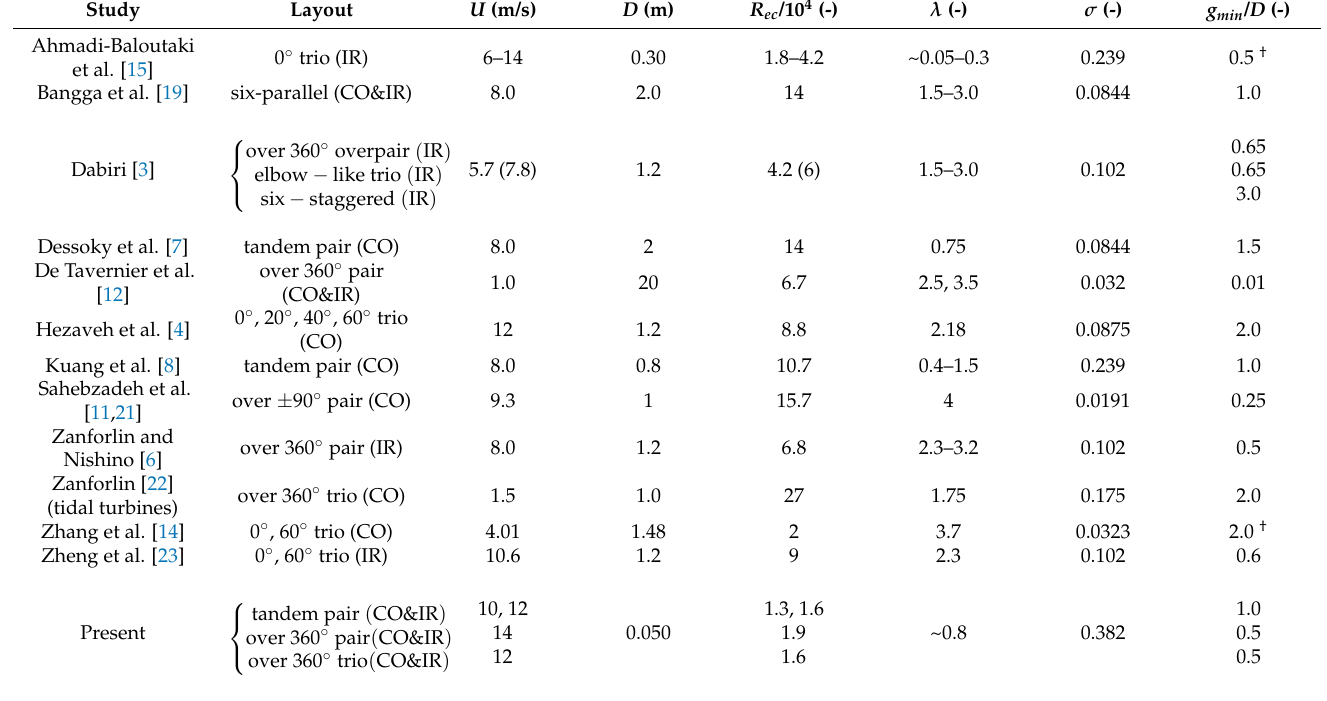
Table 1. Comparison of the parameters of the vertical-axis turbine. CO and IR represent co-rotating and inverse-rotating configurations, respectively. U is the uniform speed; D is the rotor diameter; R ec is the chord-based Reynolds number; λ = R ω / V is the tip speed ratio; and σ = Bc /( π D ) is the solidity. Values marked with † are examples of nonequilateral-triangular cluster design consisting of three